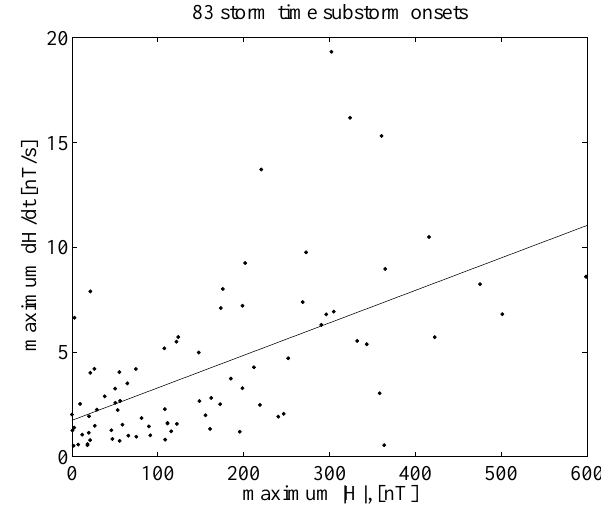
Fig. 9. Plot of | H | against corresponding largest max | d H /dt | for 83 storm time substorms . The line is the linear